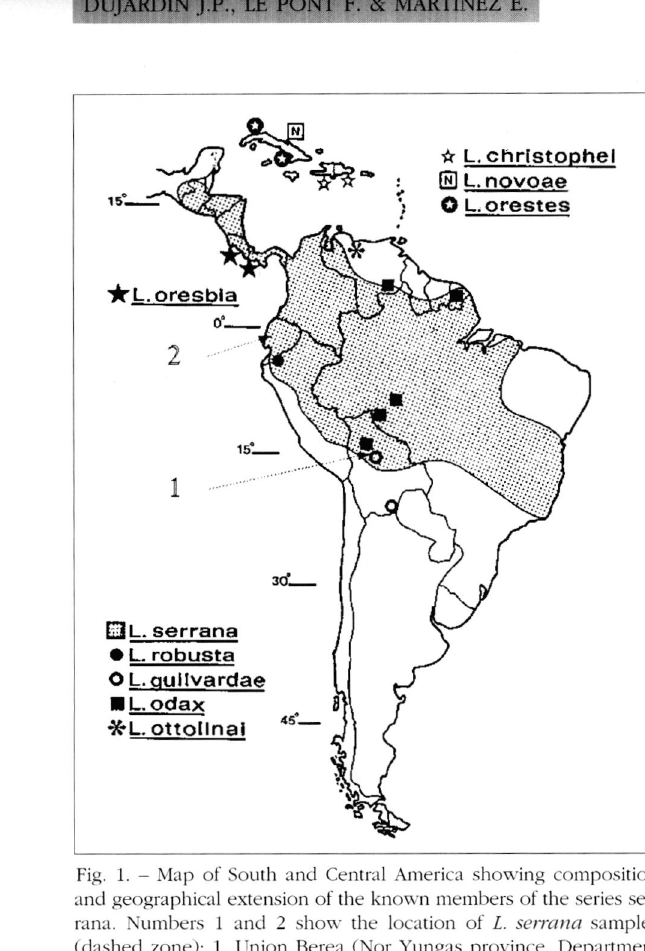
Fig. 1. - Map of South and Central America showing composition and geographical extension of the known members of the series ser rana. Numbers 1 and 2 show the location of L. serrana samples (dashed zone): 1. Union Berea (Nor Yungas province. Department of La Paz. Bolivia), also the collecting site of L. guilvardae (open circle) and 2, La Tablada (Esmeralda province, Ecuador) on the Pacific coast. L. robusta (black circle) was collected at Zumba (Zamora Chinchipe province,